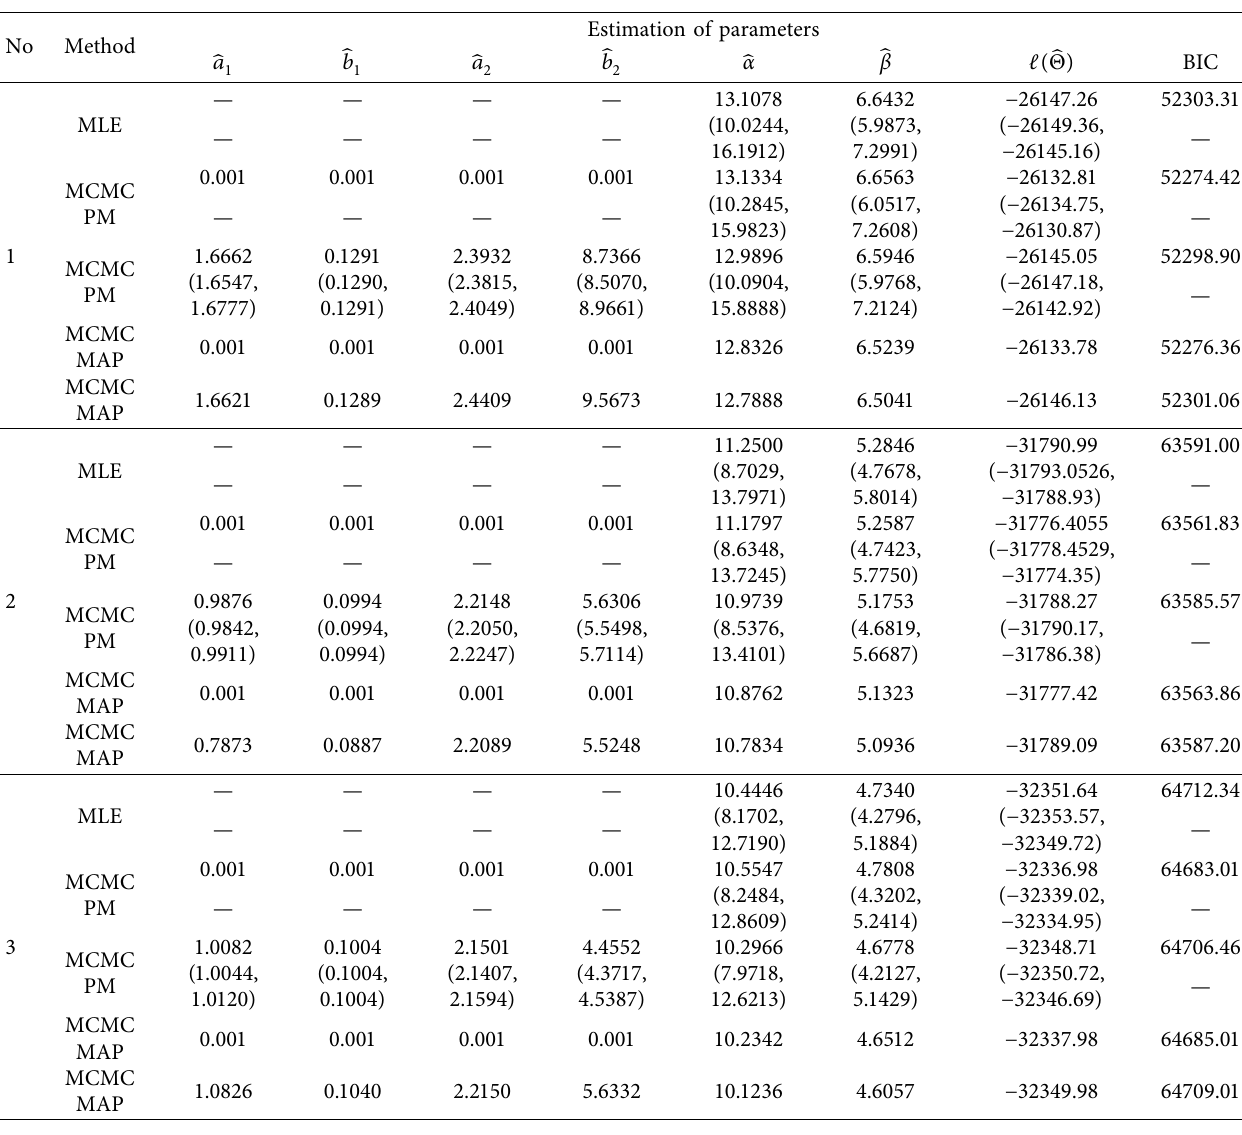
Table 1: The results of the proposed methods for the parameters using a single gamma